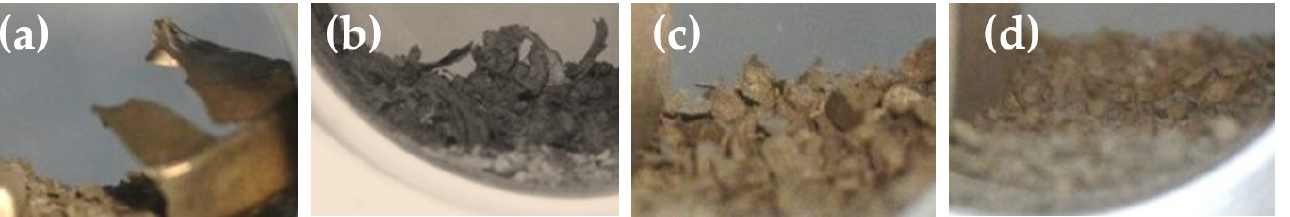
Figure 1. Specification of the hydrogenated magnetic material. ( a ) Non-decomposed coating: large coating areas remain unbroken, but are deformed by the volume expansion of the hydrogenated magnetic material, resulting in coating carcasses. ( b ) Single flakes: formed when the coating is not disintegrated by H 2 but is peeled off in flakes. ( c ) Mixed flakes: caused by better adhesion of the coating to the magnetic material and not by cohesion of the coating itself. ( d ) Disintegrated coating: small flakes caused by low cohesion or by reaction with H 2 .